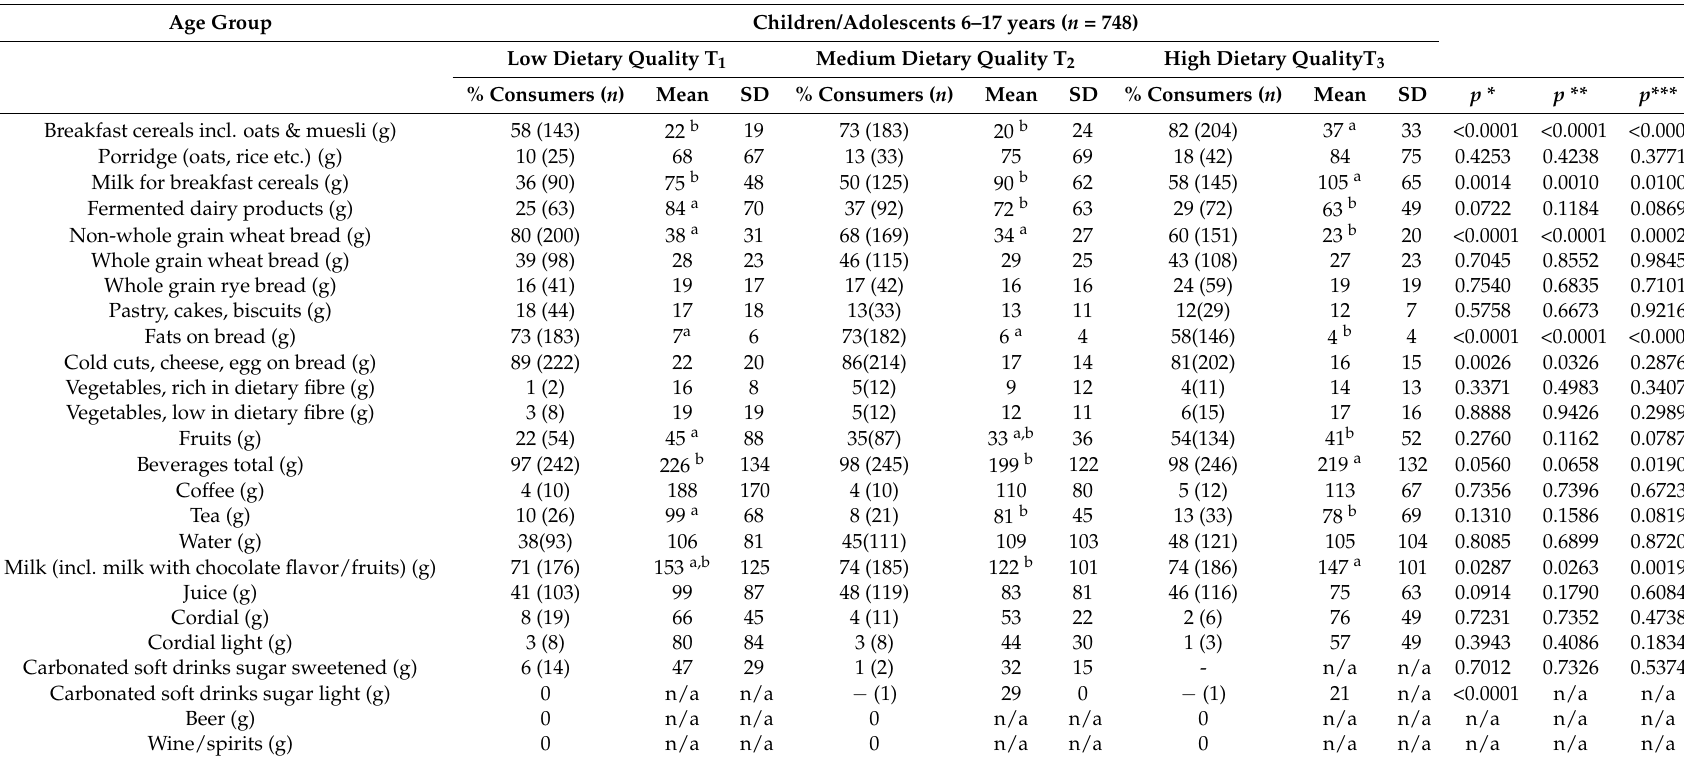
Table 6. The mean intake at breakfast of selected food groups (eaters only) among breakfast consumers across the tertiles of the NRF 9.3 score among Danish